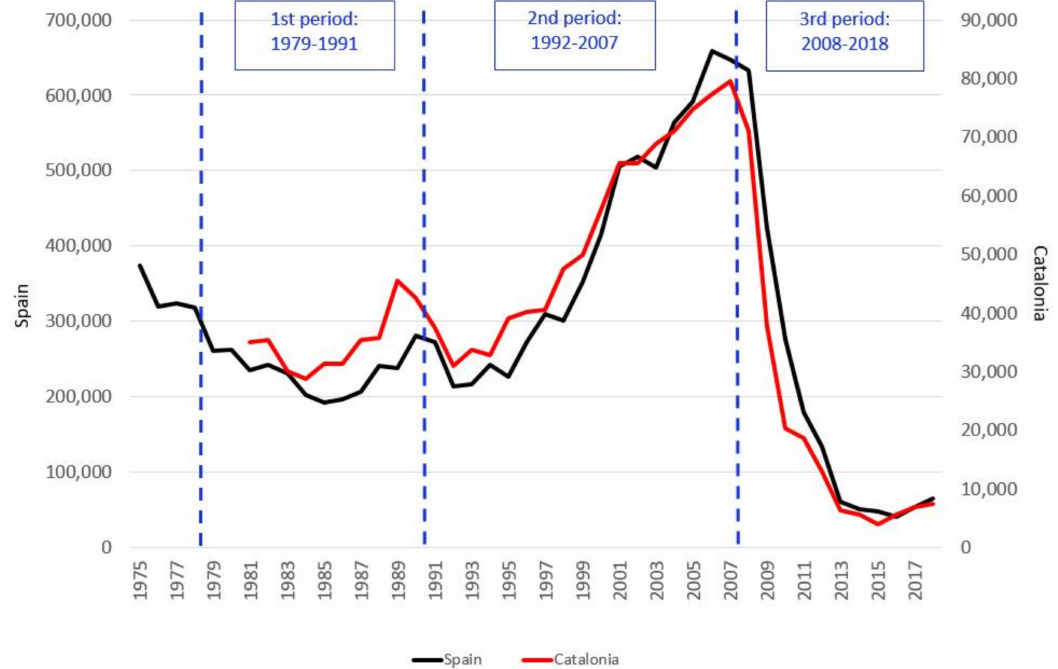
Figure 1. Property dynamics in Spain and Catalonia and urban planning periods. Housing units built in Spain ( left axis ) and Catalonia ( right axis ) (data from https://www.mitma.gob.es/vivienda (accessed on 23 March 2019) and http://habitatge. gencat.cat/ca/dades/estadistiques_publicacions/ (accessed on 20 March